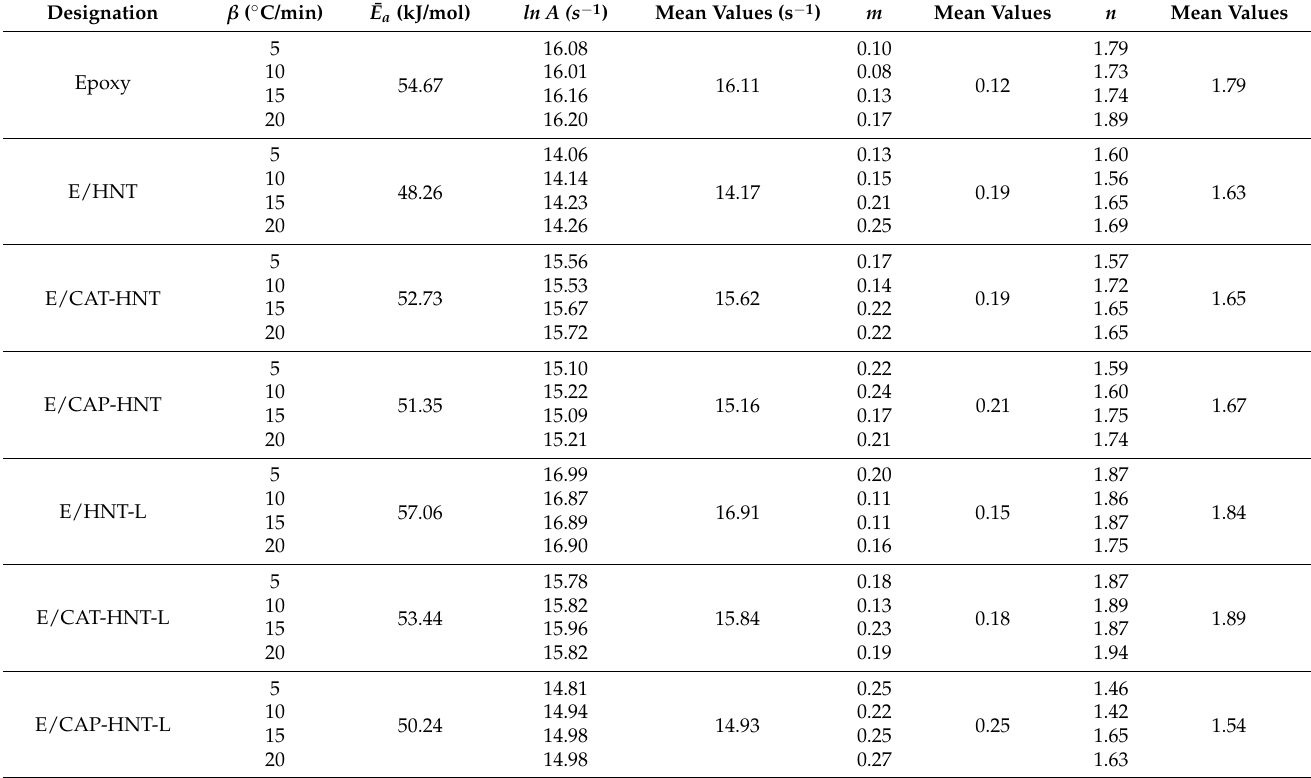
Table 4. Kinetic parameters of the studied system obtained from KAS model at different heating